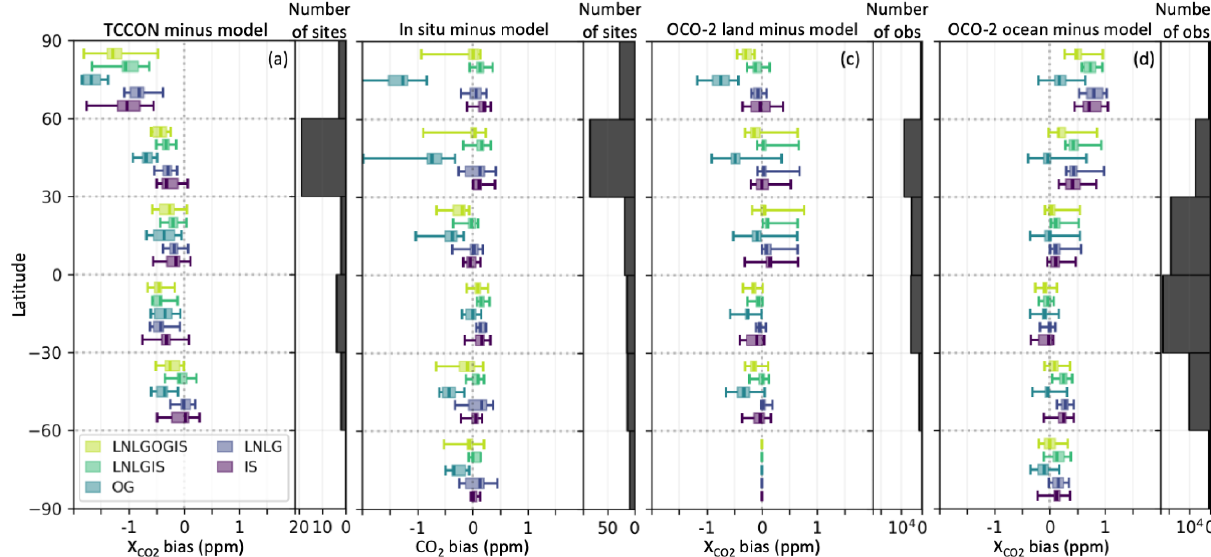
retrievals, (b) withheld in 2 retrievals. Note that NIES IS and 2